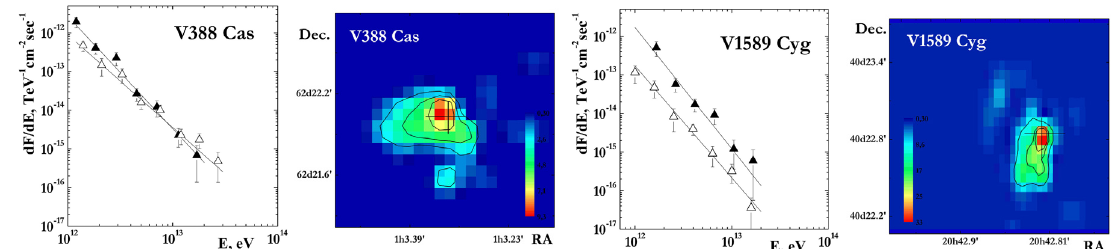
Figure 2. V388 Cas and V1589 Cyg di ff erential spectra and images by SHALON (see